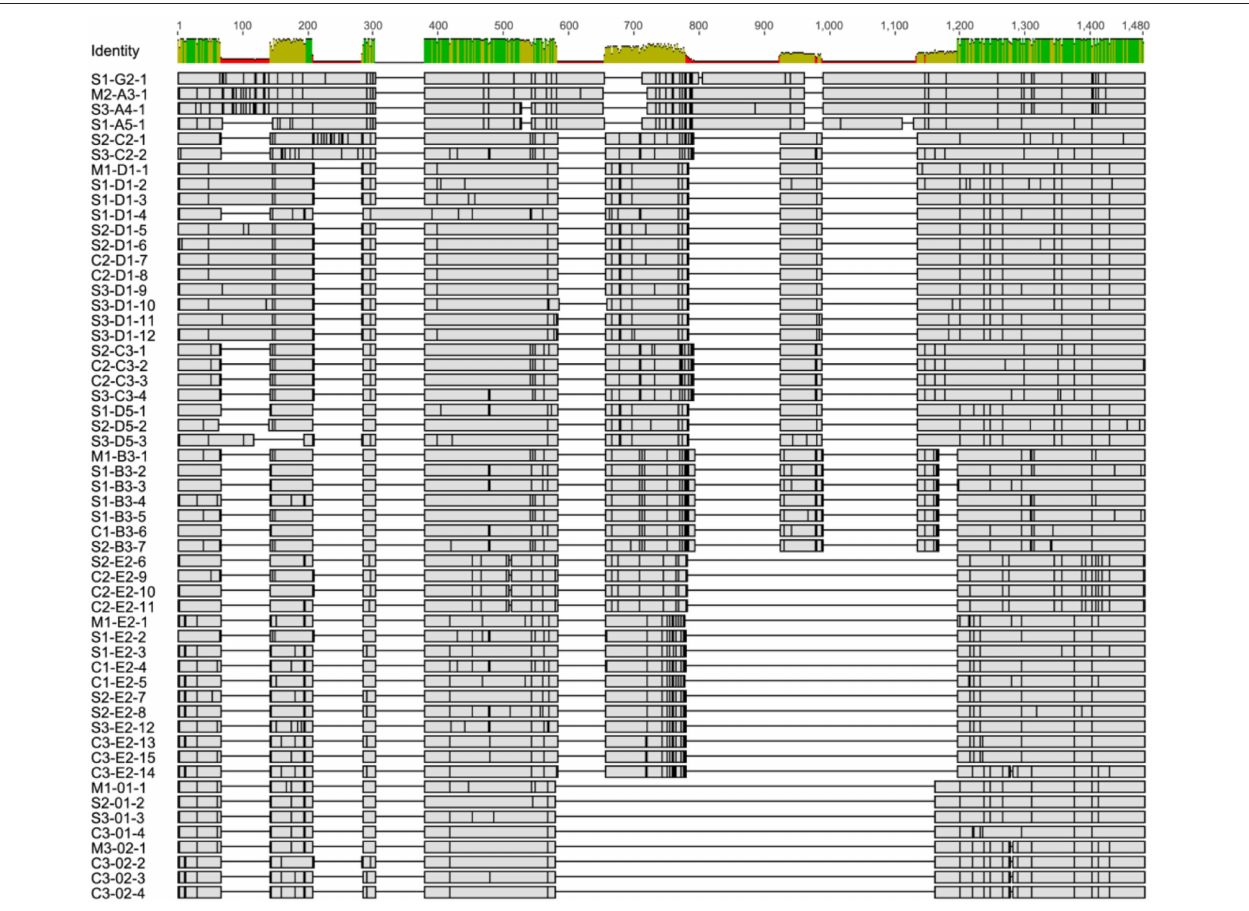
FIGURE 6 | The alignment of single cell derived SpTrf gene amplicon sequences indicate different element patterns and SNPs. All sequences were aligned using Bioedit software ( 46). The initial alignment was done with ClustalW on the deduced amino acid sequences, which was reverted to nucleotide sequences and optimized manually. The sequence identity level (percent identity) for each position is indicated at the top. Horizontal gray rectangles show regions of matching nucleotides in which SNPs are indicated as vertical black lines. Gaps are shown as black horizontal lines and indicate missing elements. Sequence names indicate source based on sperm (S), coelomocytes (C), or both (M), followed by element pattern, and sequence version number. Detailed alignment is presented in Figure S4 .